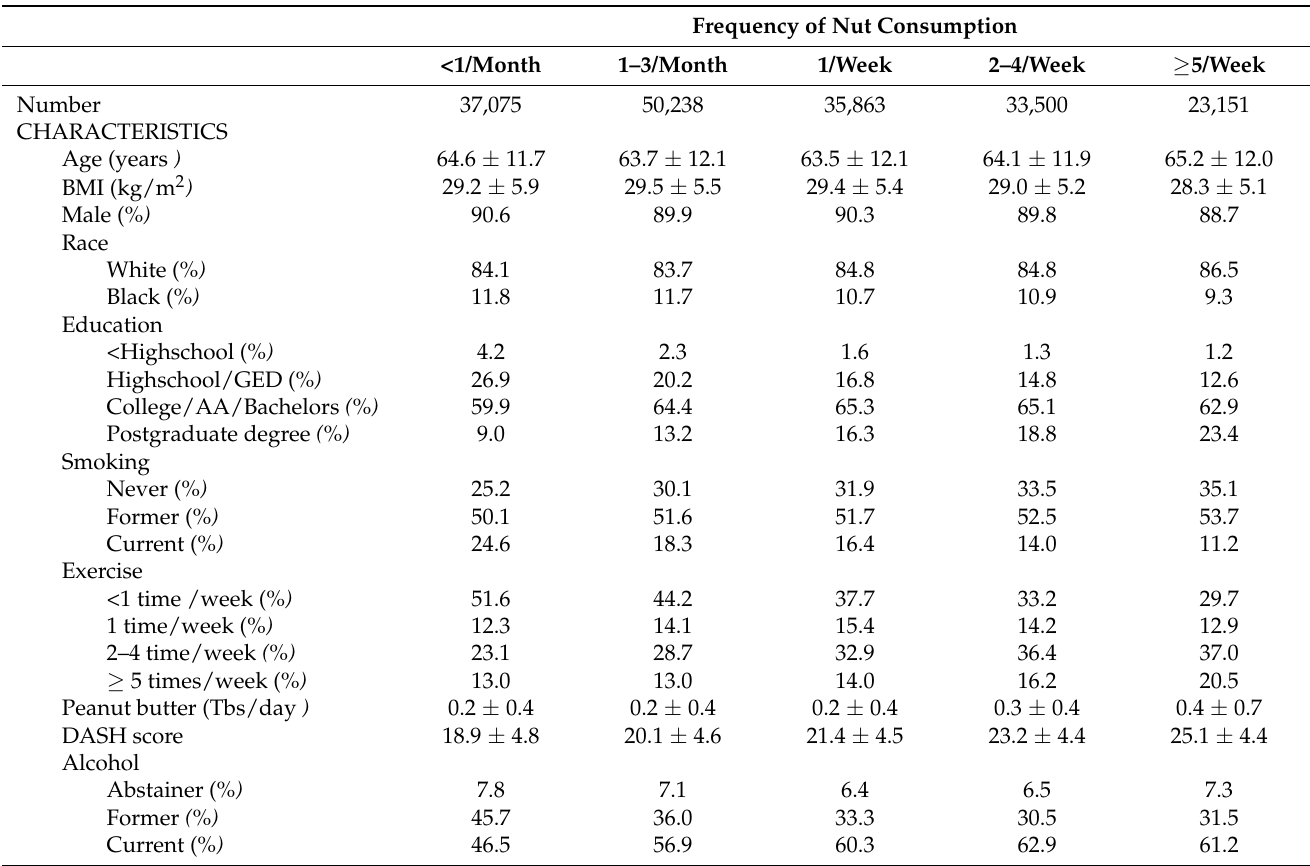
Table 1. Baseline characteristics, by frequency of nut consumption.